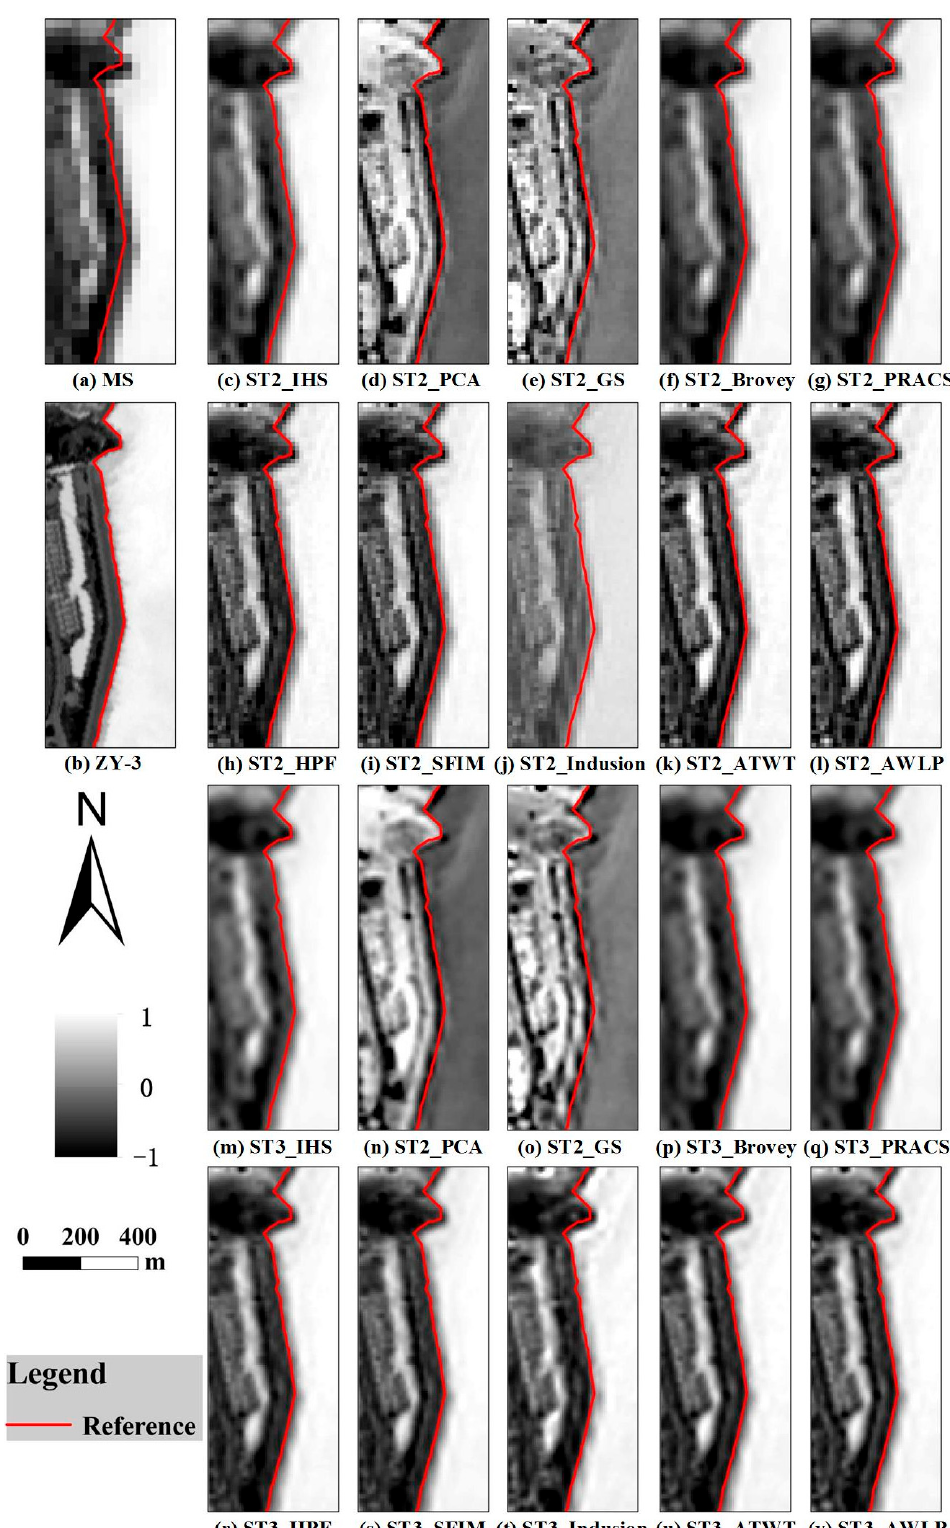
Figure 4. Normalized difference water index (NDWI) sub-images derived from original MS images and pansharpened MS images.